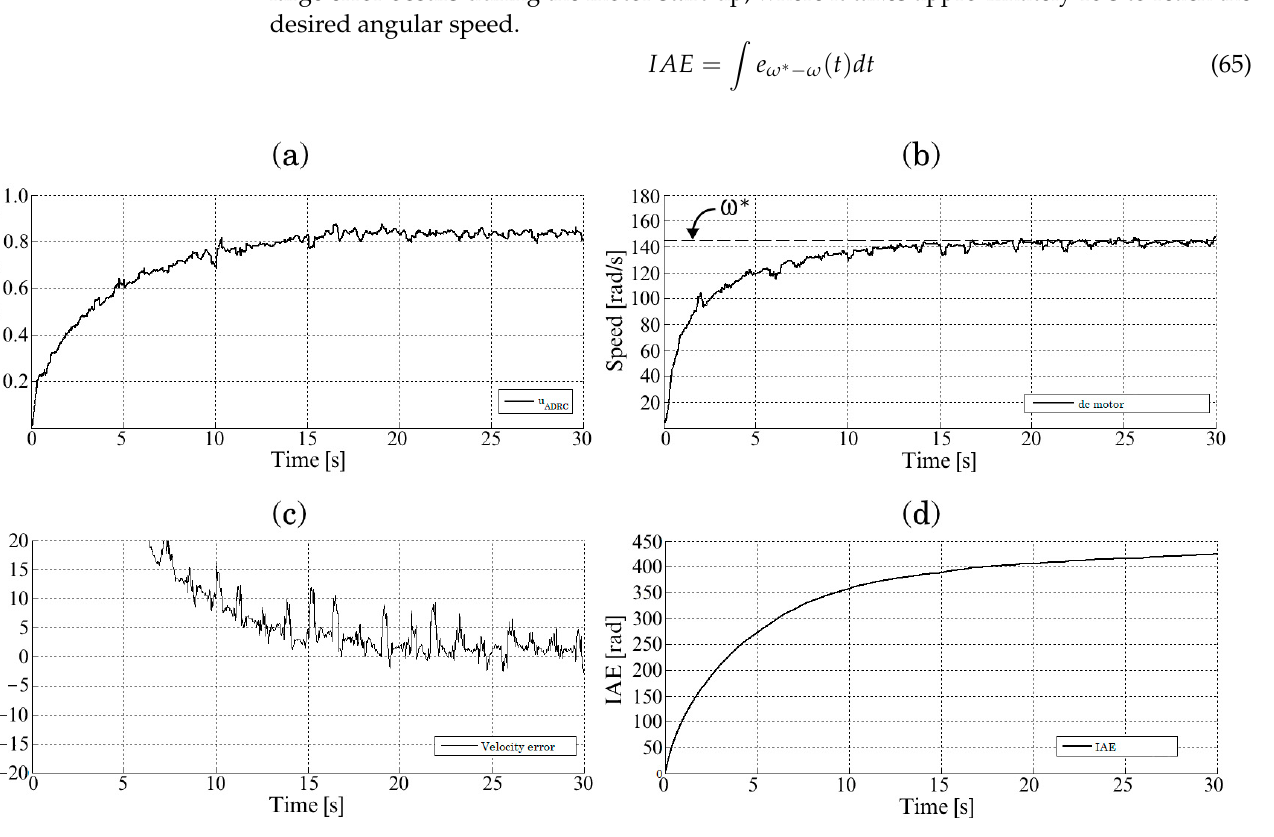
Figure 22. DC motor angular speed regulation: ( a ) ADRC approach control signal, ( b ) DC motor angular speed, ( c ) speed regulation error, and ( d ) IAE of angular speed.